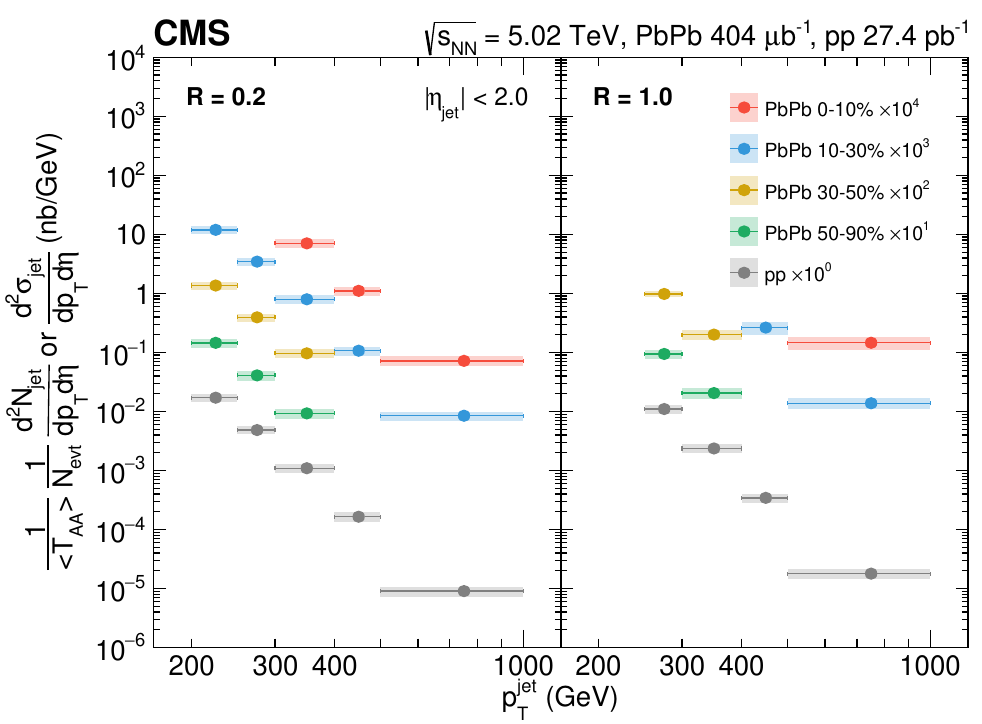
Figure 5 . Spectra of jets with | η jet | < 2 . 0 for R = 0 . 2 (left) and R = 1 . 0 (right), for pp collisions and different centrality classes of PbPb collisions. The spectra are multiplied by successive factors of 10 for clarity. The statistical uncertainties are smaller than the marker sizes, while the systematic uncertainties are shown as shaded boxes. The markers are placed at the bin